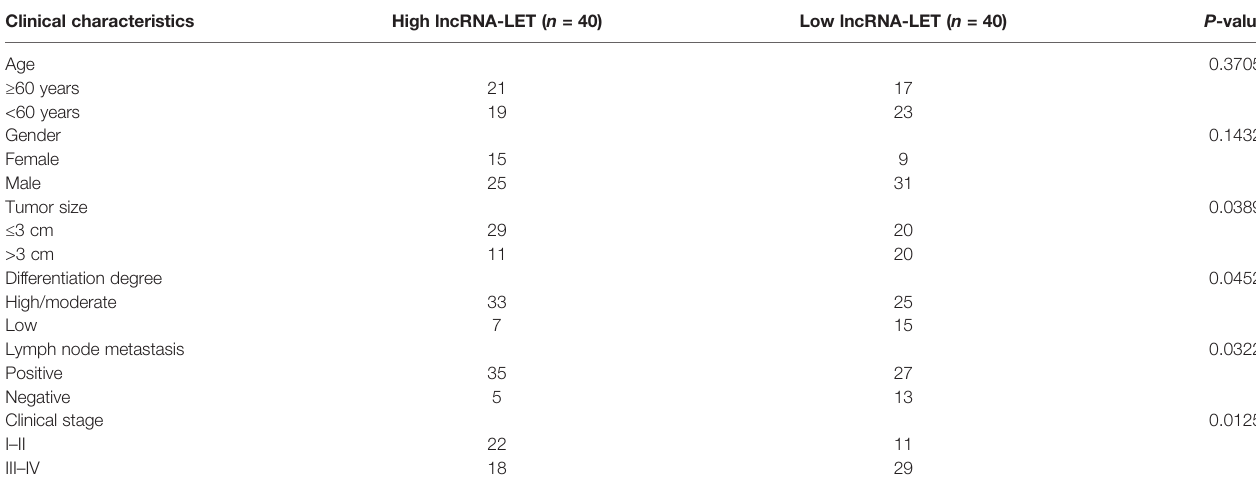
TABLE 1 | The relationship between lncRNA-LET and the clinical features of patients. Clinical